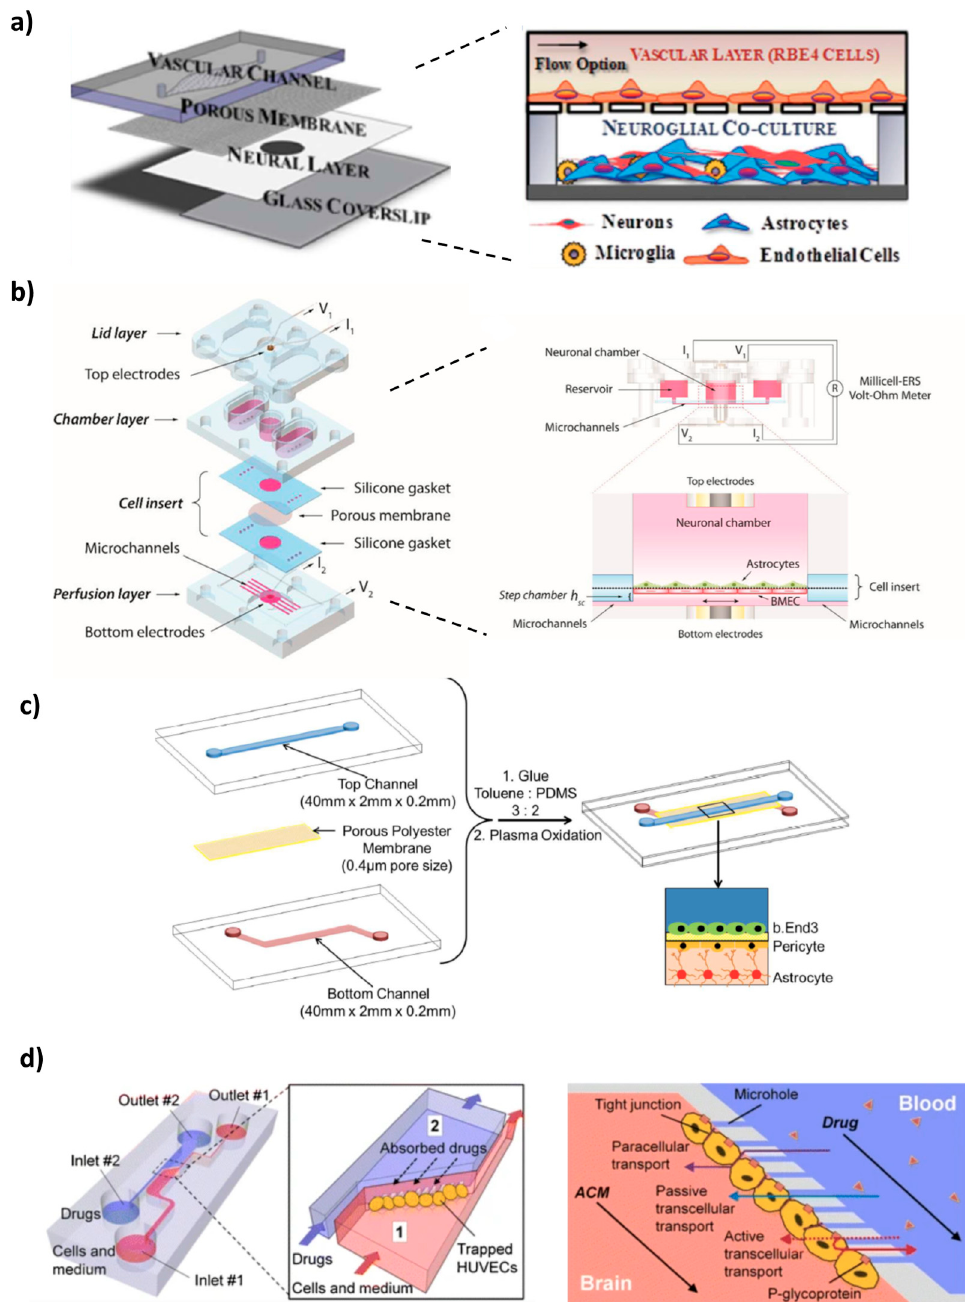
Figure 3. Examples of 2D BBB microfluidic models: ( a ) modular polydimethylsiloxane (PDMS) device to recreate the NVU by co-culture of neuroglial and endothelial cells, ( b ) pumpless microdevice that provides in vivo-like BBB properties for drug permeability screening, ( c ) multi-layered system composed of a triple culture of co-immortalized mouse brain endothelial cells (bEnd.3), mouse astrocytes (C8D1A) and pericytes, ( d ) microfluidic device that mimics the cerebral vasculature and is a reliable permeability assay system. Reprinted and adapted with permission from: ( a ) Achyuta et al. [52], ( b ) Wang et al. [53], ( c ) Wang et al. [55]. Copyright (2016) American Chemical Society, ( d ) Yeon et al. [56].